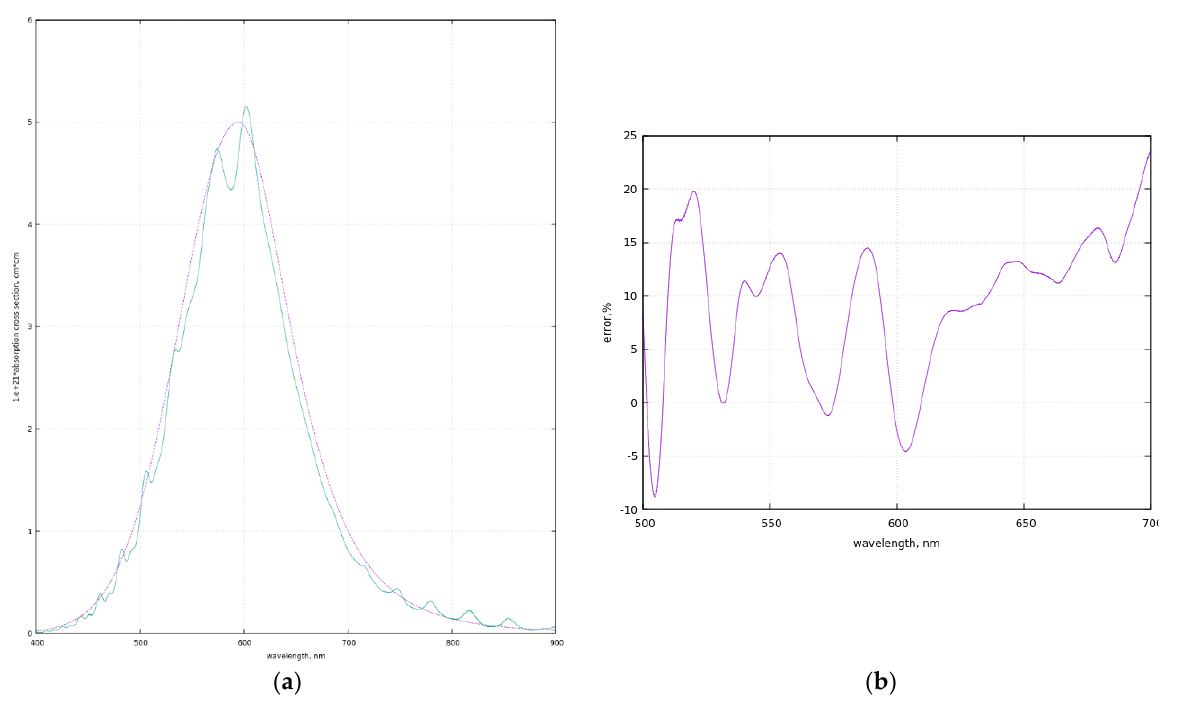
Figure 2. ( a ) The intercomparison of modelled (dashed) and experimentally measured (solid line) ozone absorption cross section (at temperature t = 233 K). ( b ) The error of the approximation for the ozone VOD.